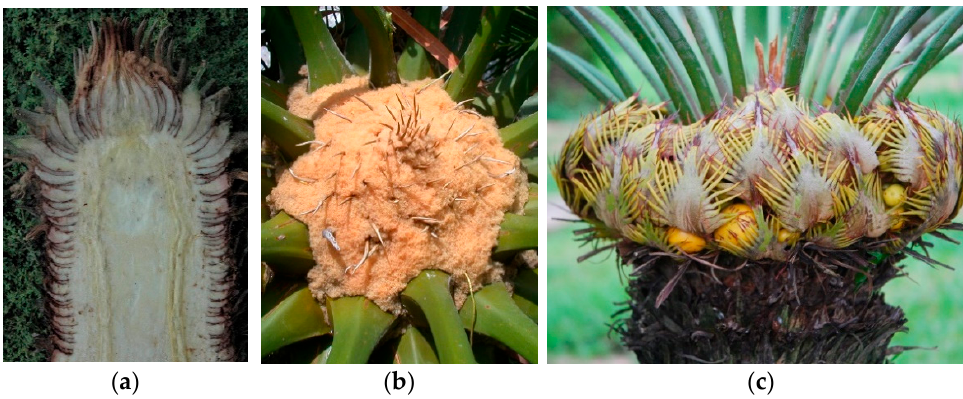
Figure 2. Aulacaspis yasumatsui can infest many surfaces on Cycas host plants that are impossible to see during visual inspections. ( a ) Cycas revoluta stem section reveals the overlapping persistent leaf bases that create cavities where the armored scale may persist. ( b ) Apex of C. tansachana K.D. Hill and S.L. Yang stem covered by dense trichomes that can conceal scale infestations. ( c ) Mature megastrobilus of C. nongnoochiae K.D. Hill revealing numerous cavities in which scale infestations may be hidden.